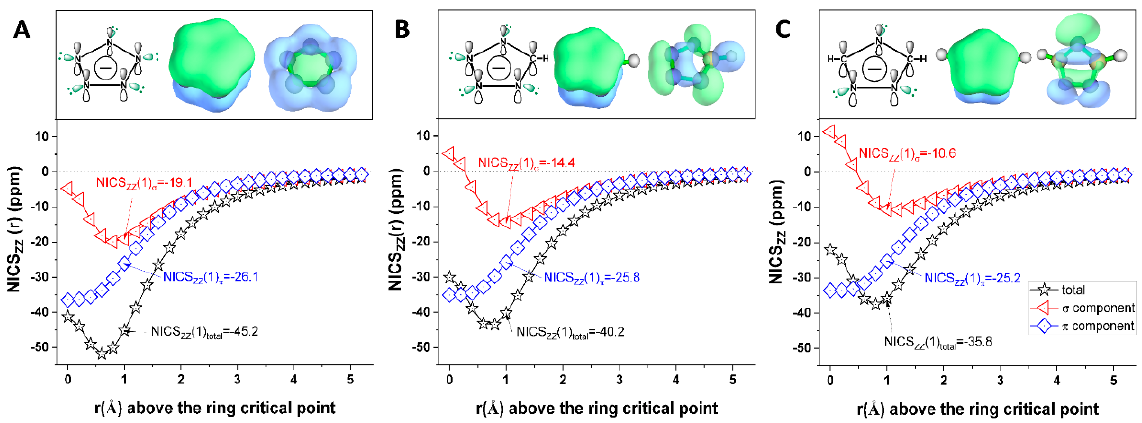
Figure 1. Confirmation of presence of dual aromaticity in ( A ) pentazole anion N 5 ¯, ( B ) tetrazole anion N 4 C 1 H 1 ¯, and ( C ) 1,2,4-triazole anion N 3 C 2 H 2 ¯. For each anion, illustrated from top left to bottom right, are the atomic orbital diagram, top view of isosurface (0.05) of the lowest π MO (MO min- π ), side view of isosurface (0.05) of the lowest σ MO containing nitrogen lone pairs (MO min- σ (LP) ), and NICS zz ( r ) (total value and its σ and π orbital components) as a function of the vertical distance relative to each ring critical point.